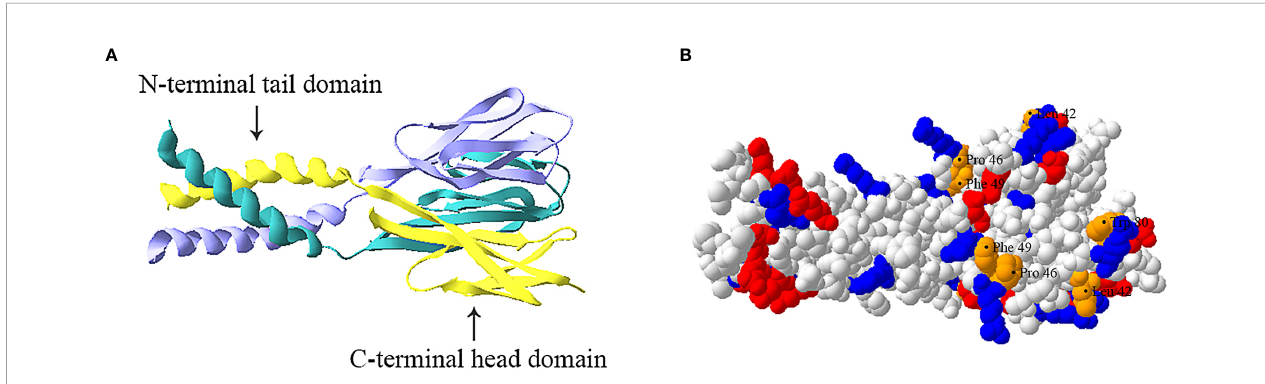
FIGURE 1 | Trimeric structure of human resistin. (A) Ribbon model of resistin trimer showing a C-terminal globular domain containing antiparallel b -sheets and an N-terminal a -helical domain. The three chains are indicated in cyan, yellow and lavender respectively. (B) Space- fi lled model of human resistin trimer. The basic (positively charged) amino acids, acidic (negatively charged) amino acids, and amino acid residues (Leu42, Pro46, Phe49, and Trp80) constituting the hydrophobic surface of the “ head ” region are shown in blue, red, and orange respectively. The structure was predicted based on the structure of mouse resistin structure (Protein Data Bank ID code 1RFX) and constructed by using the SWISS-MODEL program